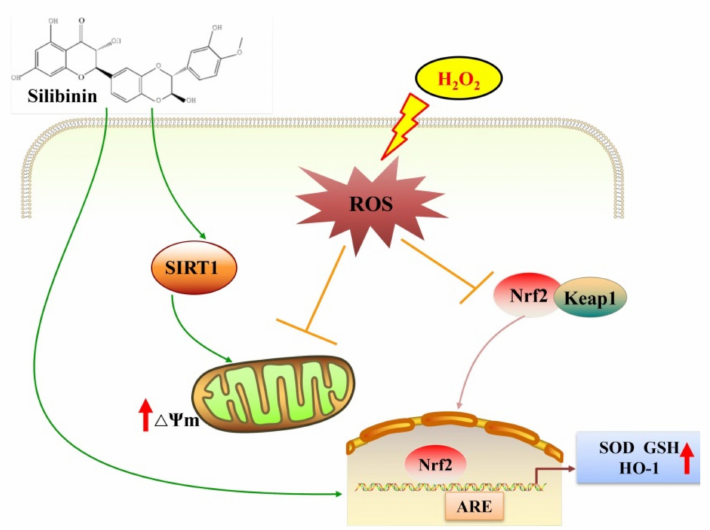
Figure 6. The hypothetical mechanisms for the alleviation of H 2 O 2 -induced oxidative stress in SH-SY5Y cells by silibinin. Excessive H 2 O 2 leads to intracellular ROS production, with subsequent oxidative stress triggering the Nrf2/HO-1 pathways. Silibinin attenuates H 2 O 2 -induced oxidative stress in SH-SY5Y cells, likely through improving mitochondrial function and upregulating the Nrf2/HO-1 pathways to increase the expression of antioxidant